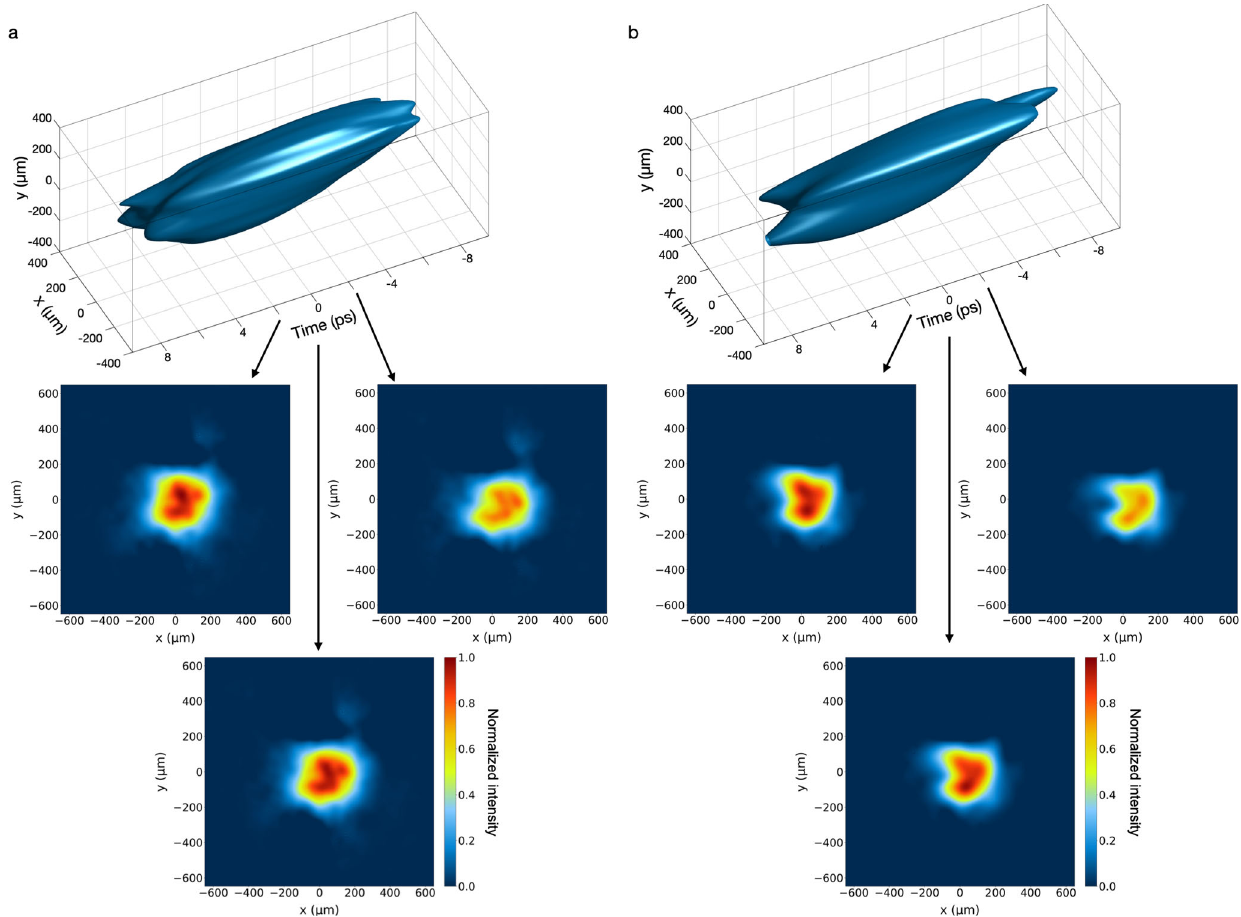
Fig. 3 Spatiotemporal distributions of example pulses with rogue events. a , b Reconstructed spatiotemporal intensity distributions of two example pulses with rogue events. These plots are achieved by calculating a contour from the beam pro fi les at each temporal point. Spatial distributions around the peaks of the pulses are presented separately by normalizing to local maxima and are show in insets connected to the main panel by (Fig. 2b, d), spatiotemporal measurements con fi rm that pulses with rogue events feature enhanced beam qualities. Spatiotem- poral evolutions of these rogue and noise-like pulses are demonstrated in Supplementary Movies 1 – 4.